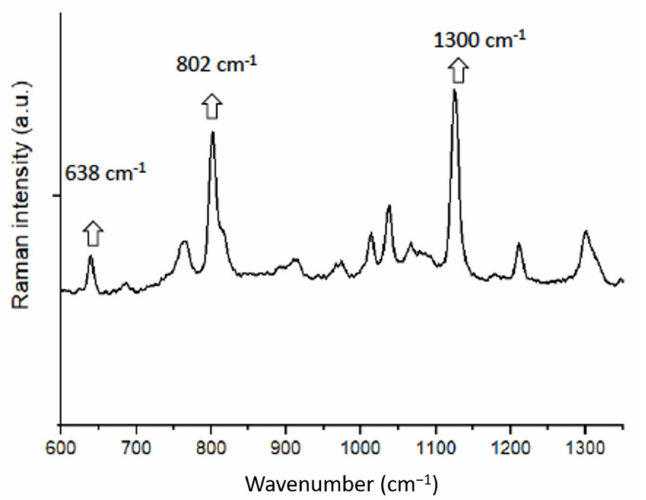
Figure 4. Micro-Raman analysis of silica powder at an excitation wavelength of 532 nm laser showed a spectrum having prominent peaks at 638, 802, and 1300 cm − 1 , characteristic of Si